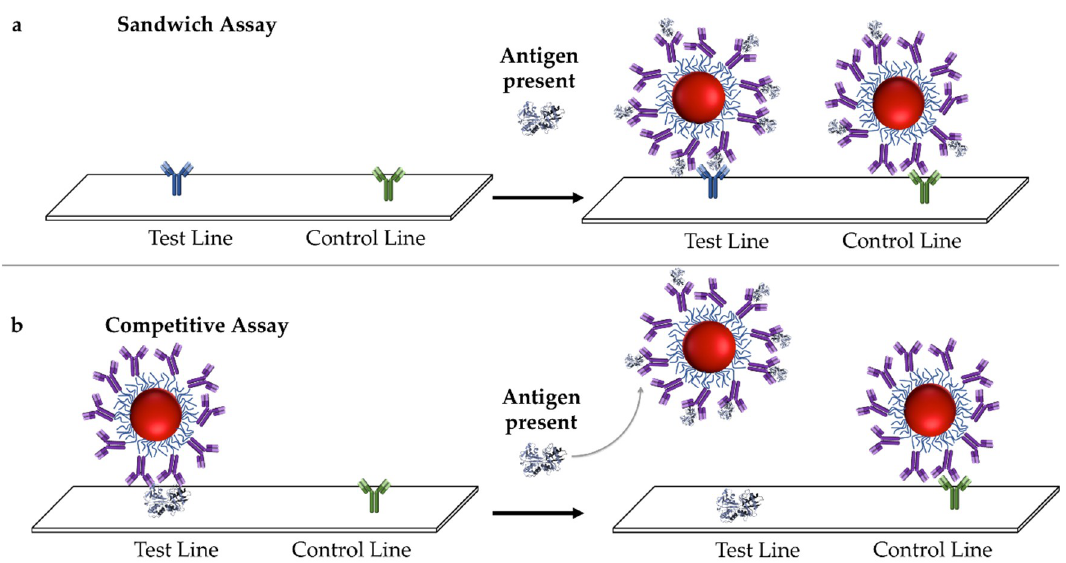
Figure 3. Signal origin in an LFA using the ( a ) sandwich format, where an antibody specific for the antigen is immobilized on the test line, and ( b ) competitive format, where an antigen is immobilized on the test in and pre-bound with the nanoparticle (NP)-antibody conjugate. If the antigen is present in the fluid, the NP-antibody conjugate is displaced from the test line, resulting in a loss of color from the test line.